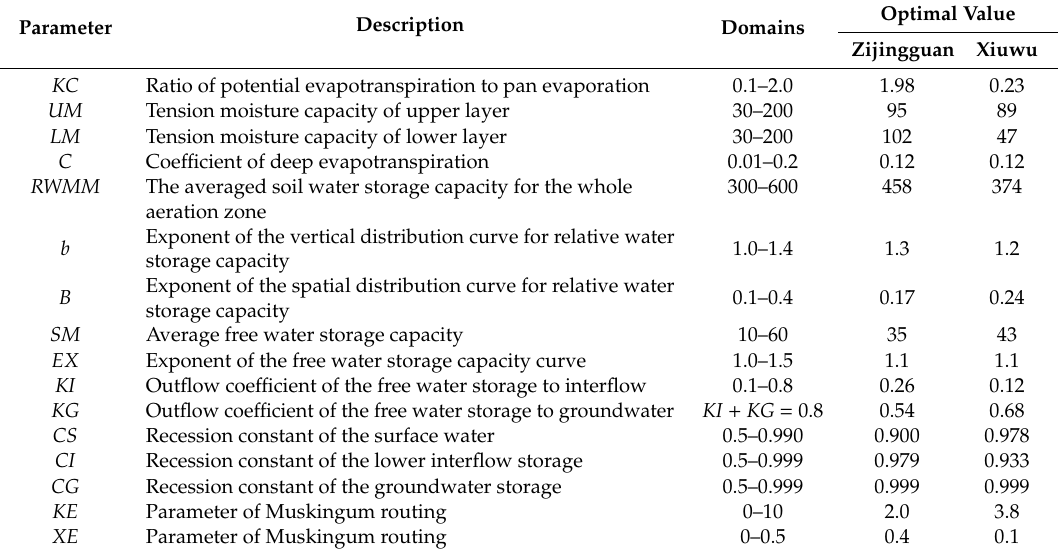
Table 1. Parameters, their descriptions and domains for Zijingguan Basin and Xiuwu Basin.